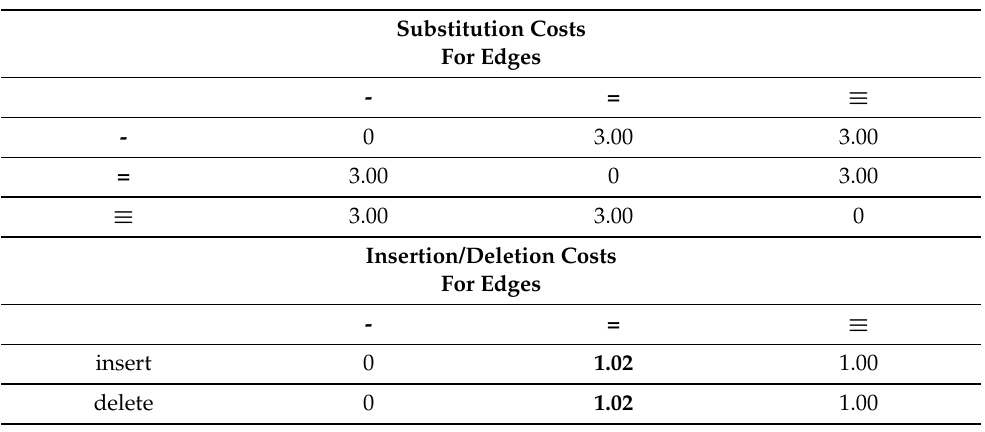
Table 8. Substitution, insertion and deletion costs of edges obtained with our